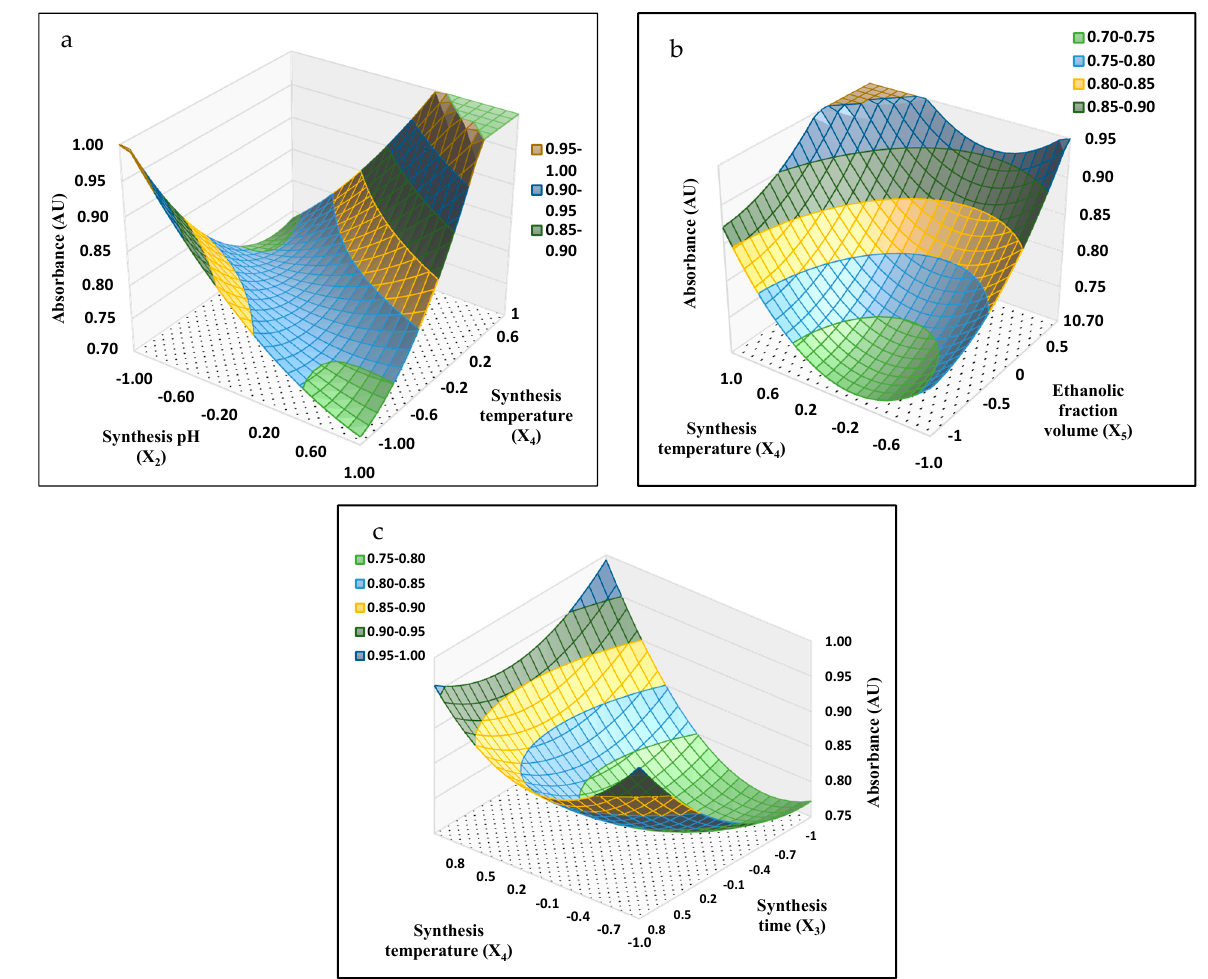
Figure 6. Three-dimensional response surface plots for synthesis temperature on absorbance of the synthesized AgNPs conjugated with the ethanolic fraction of Lepechinia meyenii (salvia), showing variable interactions: ( a ) synthesis pH, ( b ) ethanolic fraction and ( c ) synthesis time.